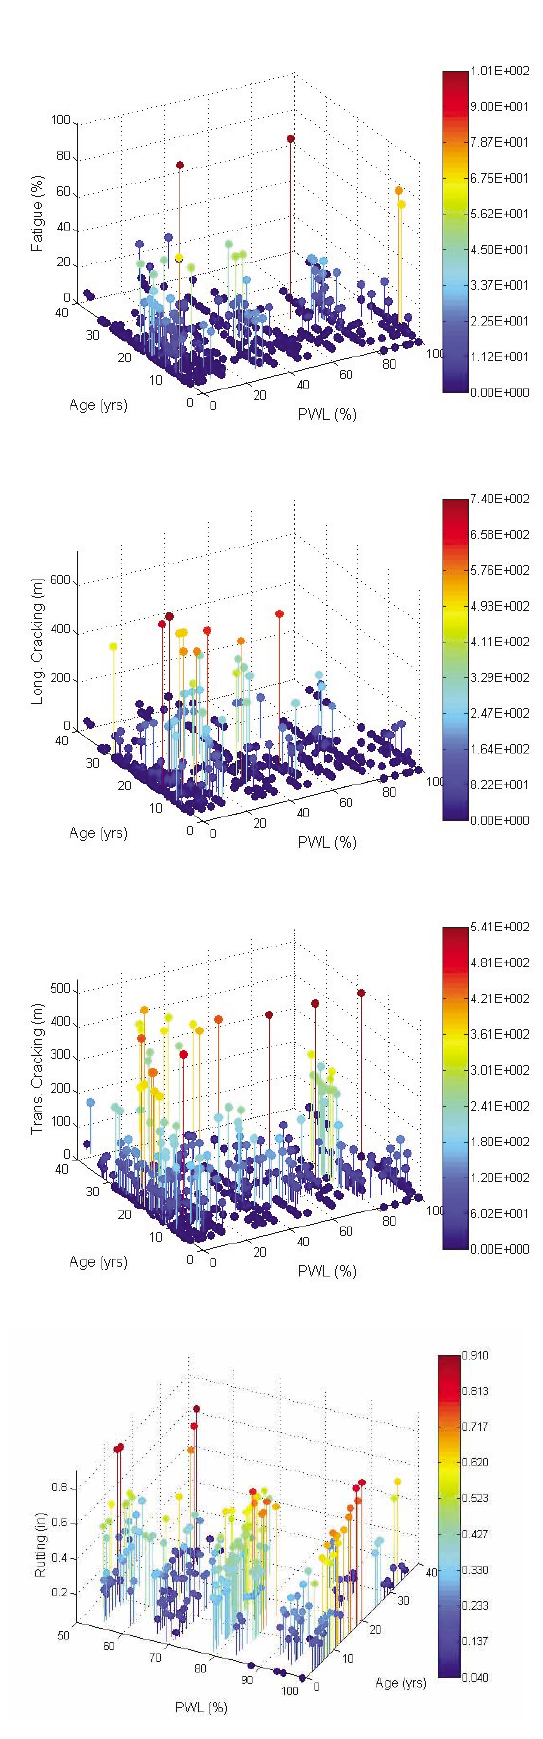
Fig. 2. Pavement performance versus PWL (plant air voids) and age from LTPP